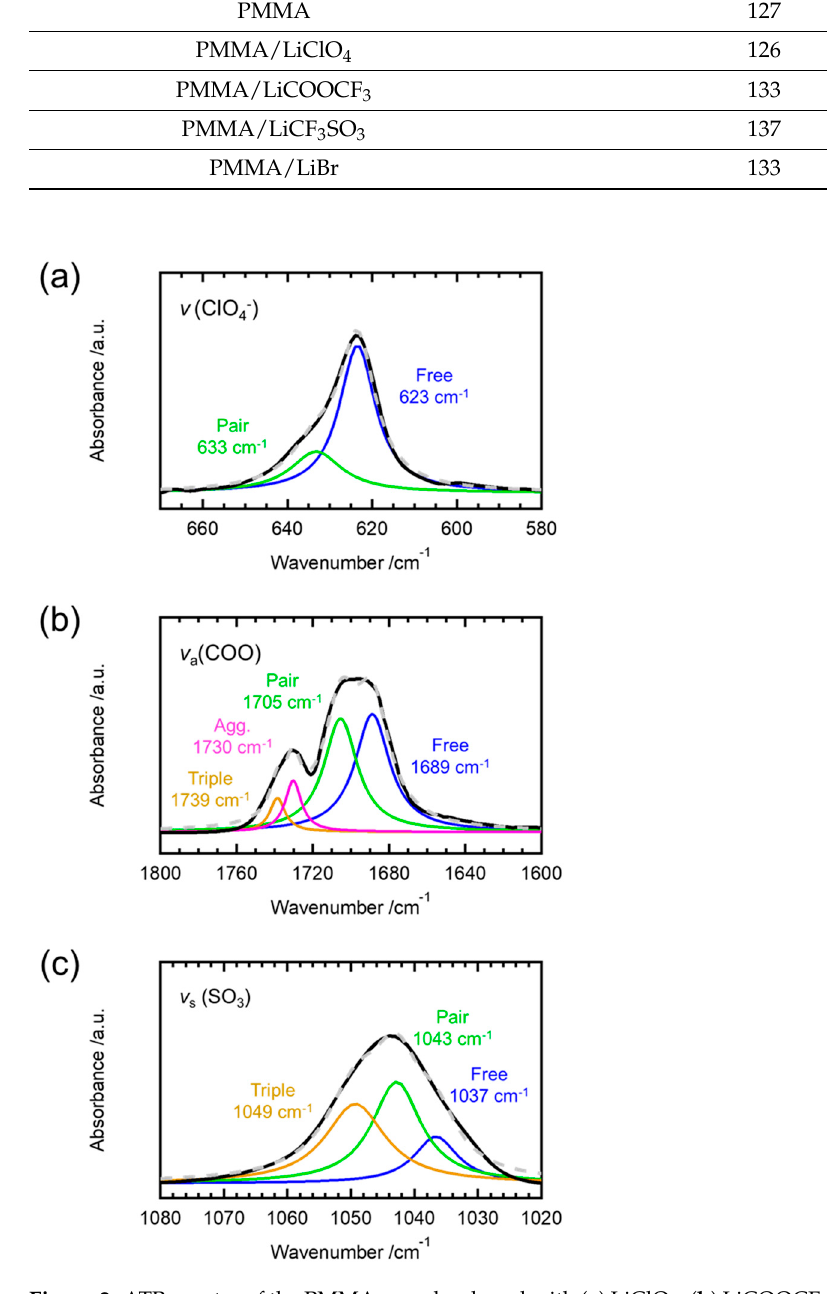
Figure 2. ATR spectra of the PMMA samples doped with ( a ) LiClO 4 , ( b ) LiCOOCF 3 , and ( c ) LiCF 3 SO 3 . Their concentrations of lithium salts are [Li]/[C=O] = 0.07. The black lines denote the experimental spectra and the dashed gray lines denote the computational